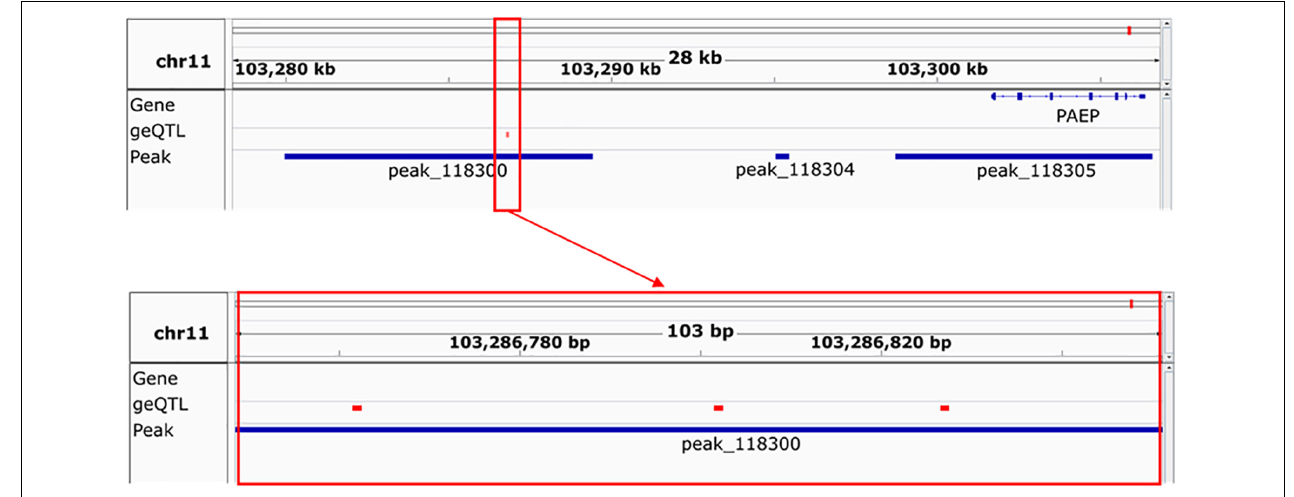
FIGURE 11 | An example of the utility of this data. Peak 118,300, whose location is shown in the upper panel, is significantly 2-fold higher in mammary gland than other tissues and its height (not shown) correlates ( r = 0.71, P = 0.002) with the expression of the gene PAEP. Three geQTL, shown in the red box in the upper and lower panels, which correlate with the expression of PAEP in milk cells, can be found in this